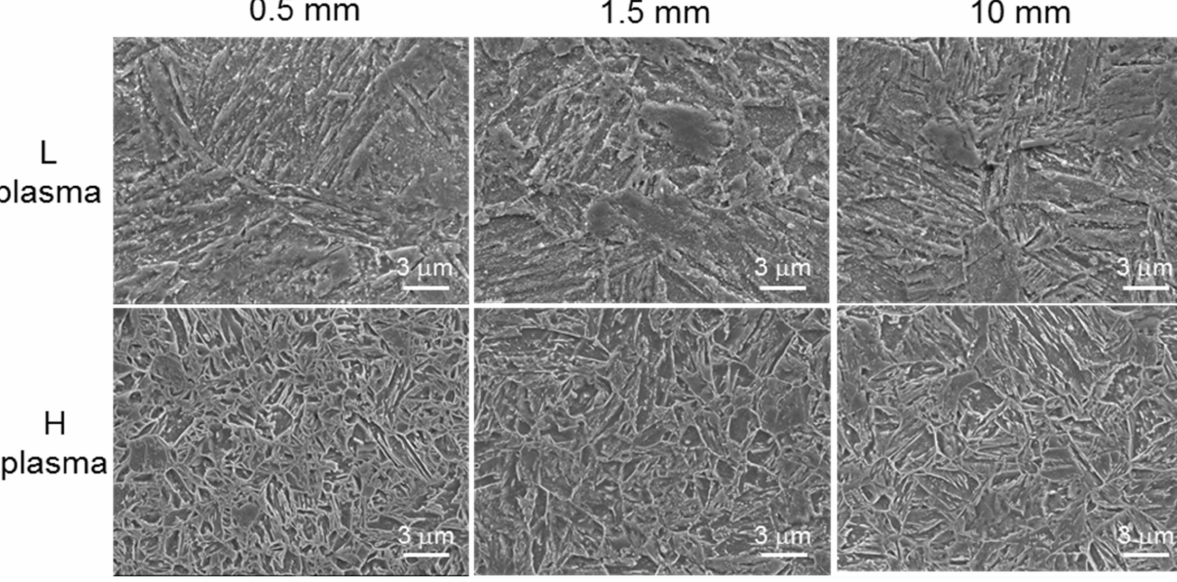
Figure 4. SEM images of grain structure in Steels L and H cut using plasma cutting method: left to right, at the cut edge, point of minimum HV, and far away from the cut edge (base